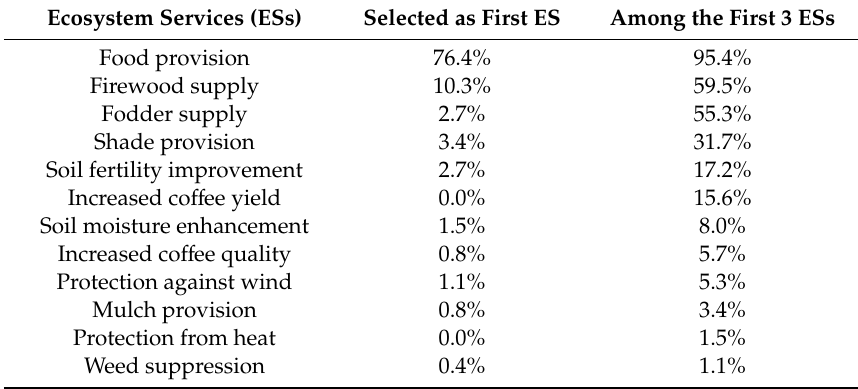
Table 1. Ranking of Ecosystem services on a household level.